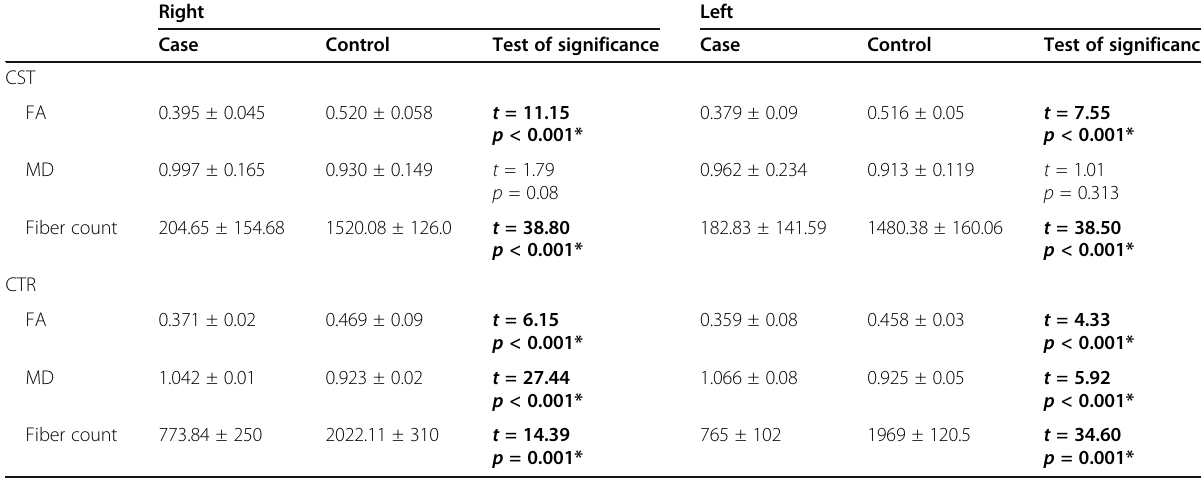
Table 2 Mean FA, MD values, fiber counts, and standard deviations measured in both CST and thalamic radiations in CP group and control group